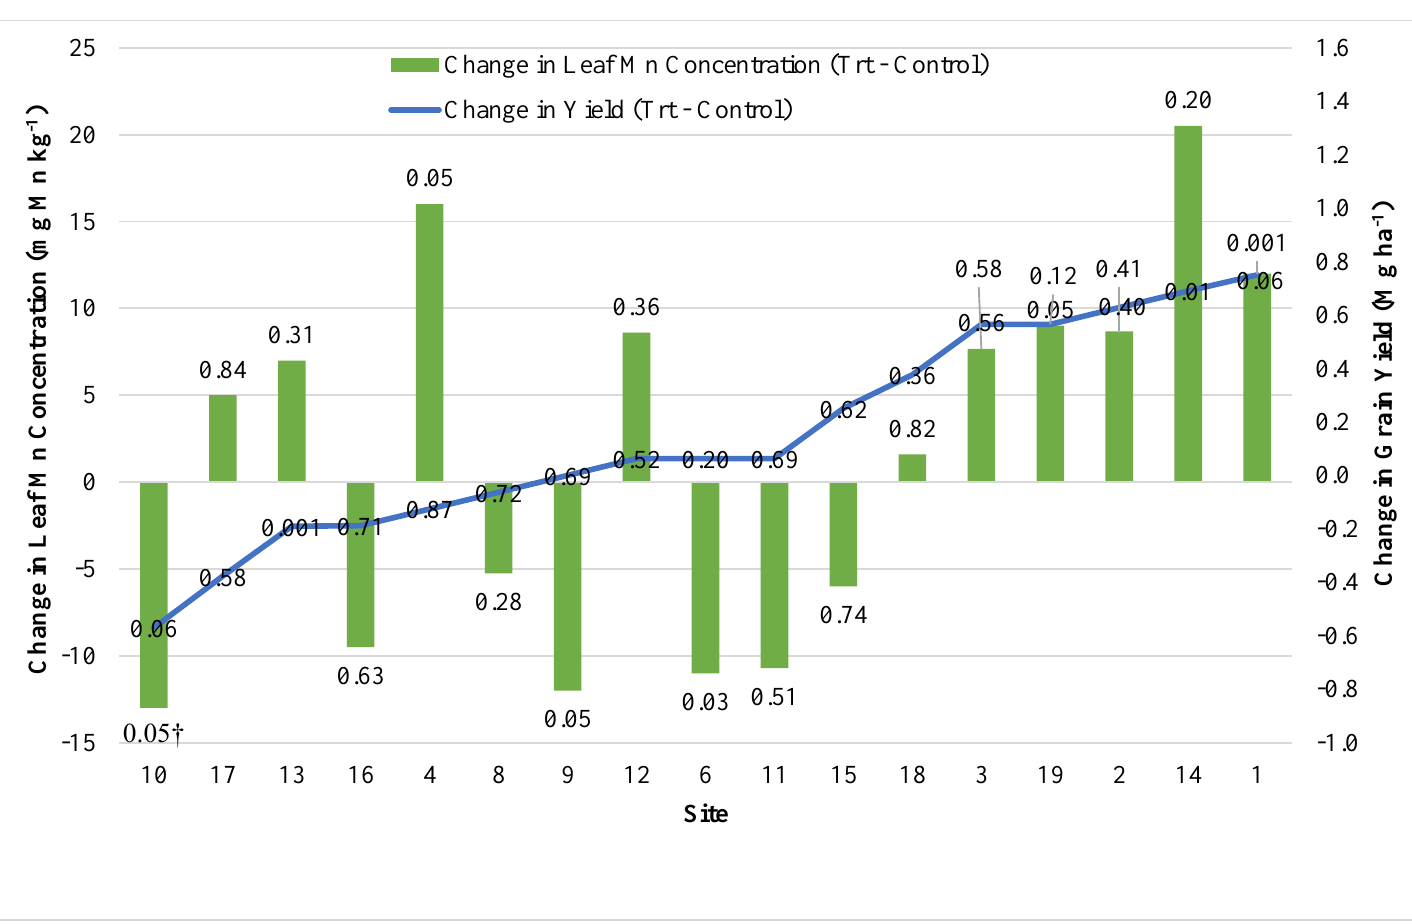
Figure 5. Leaf Mn concentration (bars) and maize grain yield (line) responses to foliar Mn application for 17 sites. Data labels on both the line and bar graphs indicate p -values † for mean comparison differences. The correlation coefficient (r) for the relationship of changes in tissue Mn concentration and grain yield due to foliar Mn application is 0.54.